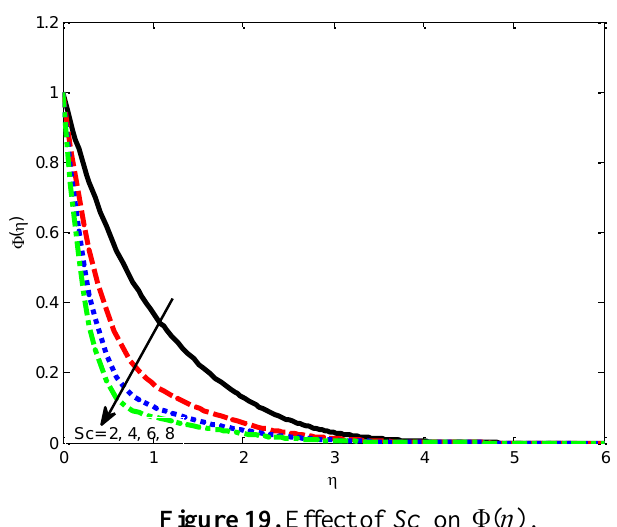
Figure 19. Effect of Sc on ( ) 